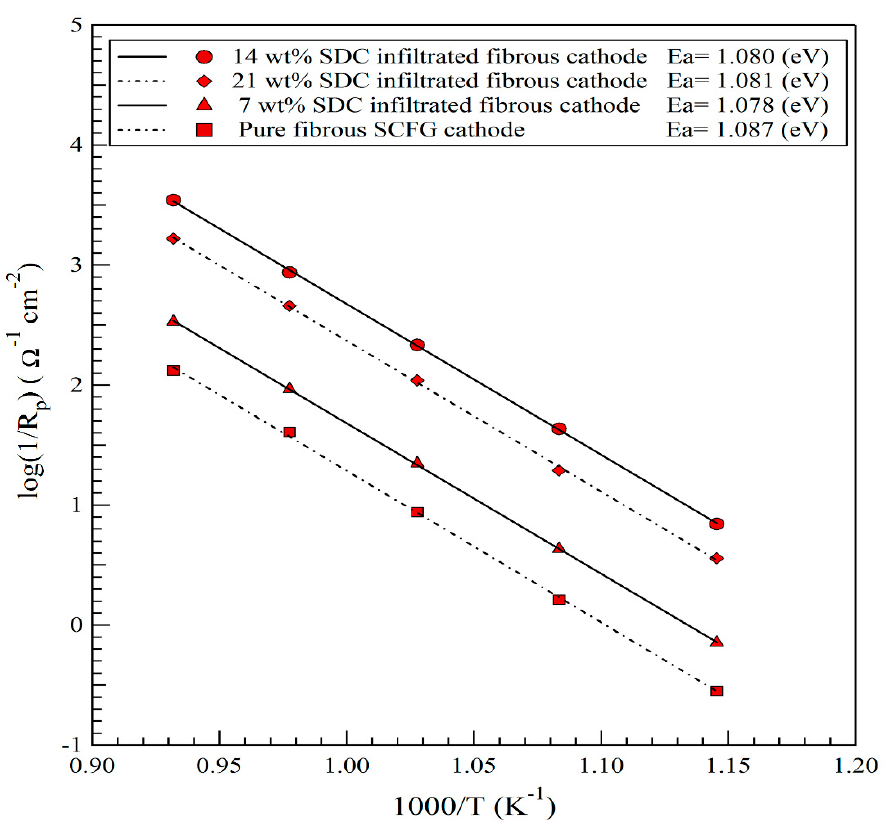
Figure 6. Arrhenius curve of polarization resistance of various fibrous SCFG cathodes, including pure and infiltrated with about 7, 14, and 21 wt% SDC nanoparticles.